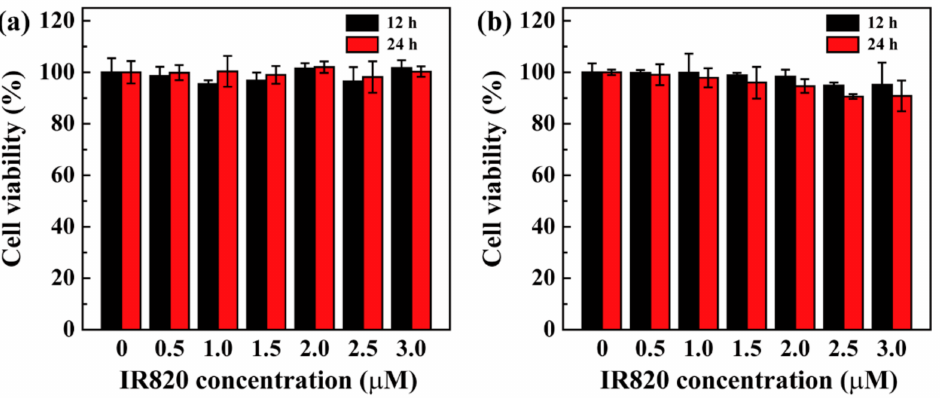
Figure 5. Relative viability of U87MG cells ( a ) and L929 cells ( b ) co-incubated with Ac-PR/IR820 dendrimers for 12 h and 24 h, measured by CCK-8